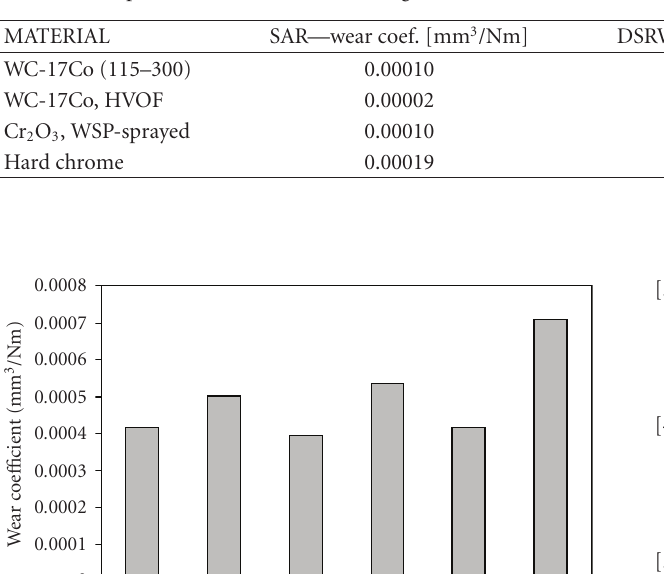
Table 3: Comparison of the best WSP coating of WC-Co (115–300) with other materials studied by the authors under the same conditions.